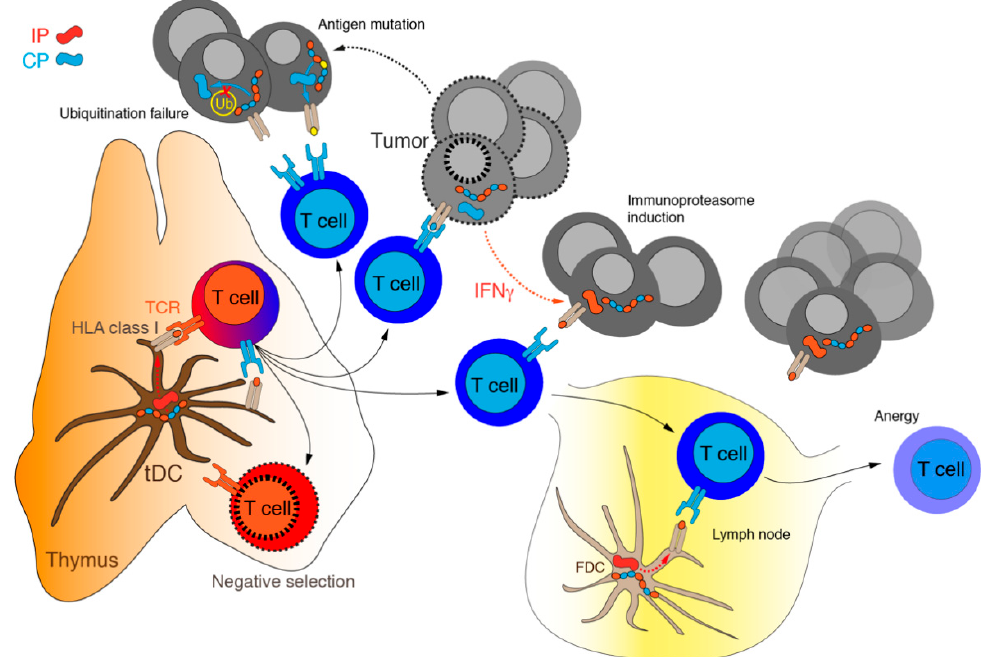
Figure 4. Mechanisms of tumor immunoescape. T cell clones that passed negative selection recognize a limited number of tumor self-antigens. Moreover, cancer cells may escape from cytotoxic CD8+ T cells by (i) IFN γ -mediated induction of immunoproteasome with altered pattern of antigens processing, (ii) mutation of the antigen leading to the failure of the recognition by TCR, and (iii) inactivation of intracellular ubiquitination of tumor antigens caused by either suppression of expression or functional mutation of the E2/E3 ligases specific to tumor antigens.